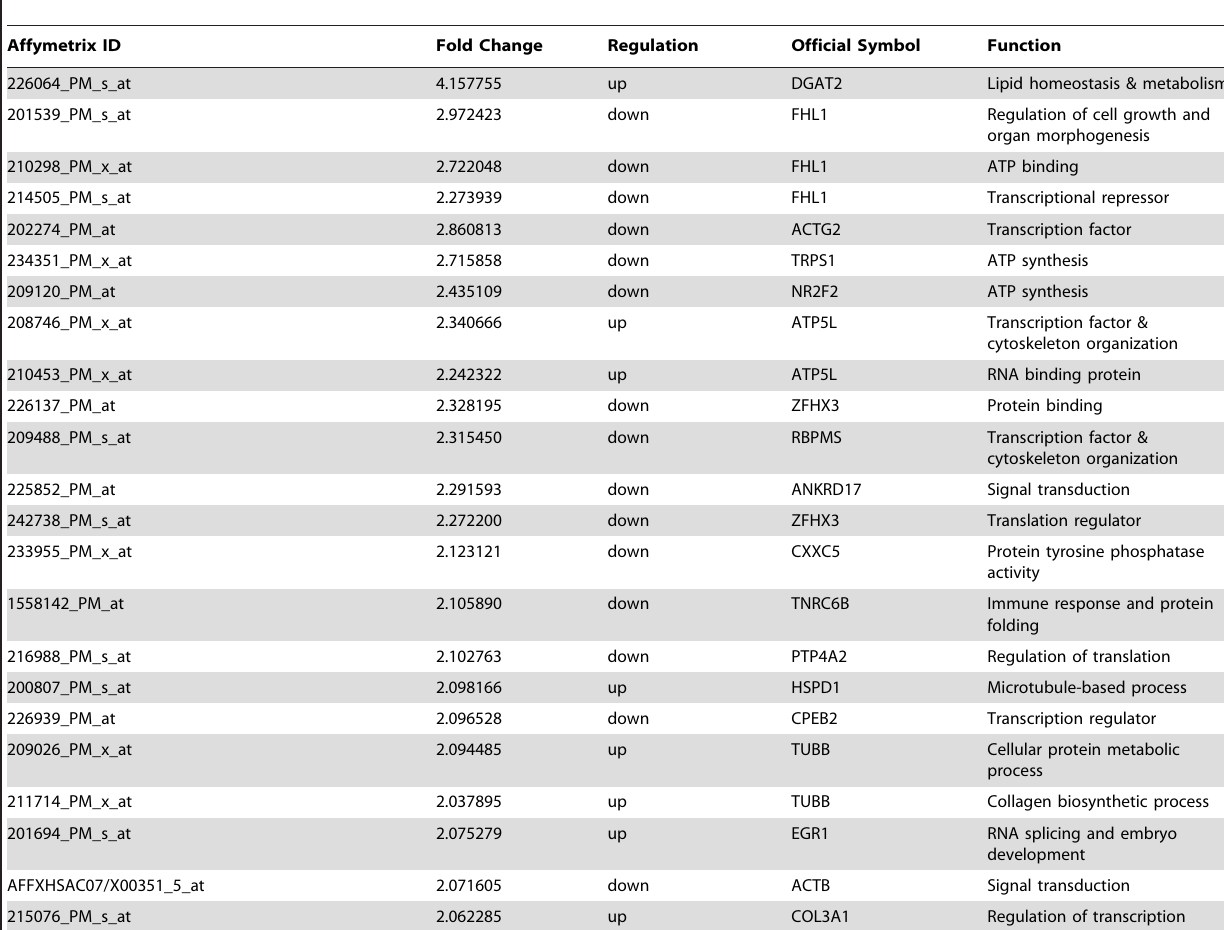
Table 1. Differentially expressed genes identified in male versus female elephant adipose